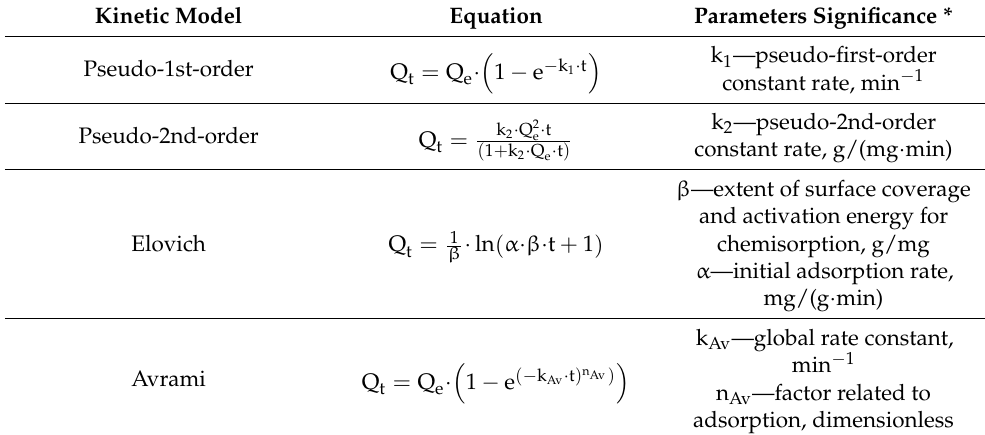
Table 9. Kinetic models nonlinear equations.